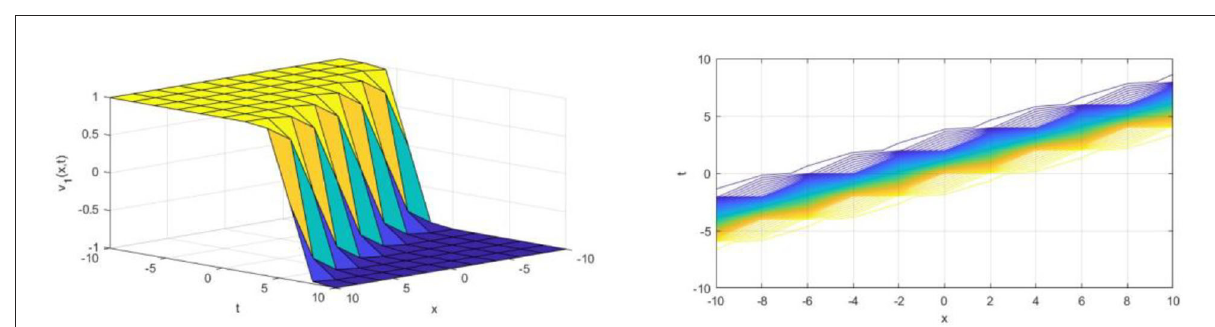
FIGURE5 The kink wave solution of v 1 ( x , t ) in 3D and contour.